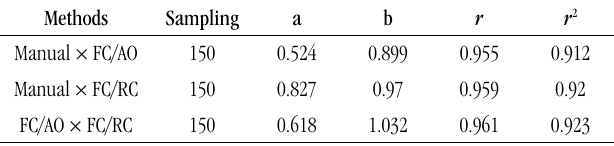
tABLE 1 – Comparison of reticulocyte count (%) between different methods Methods